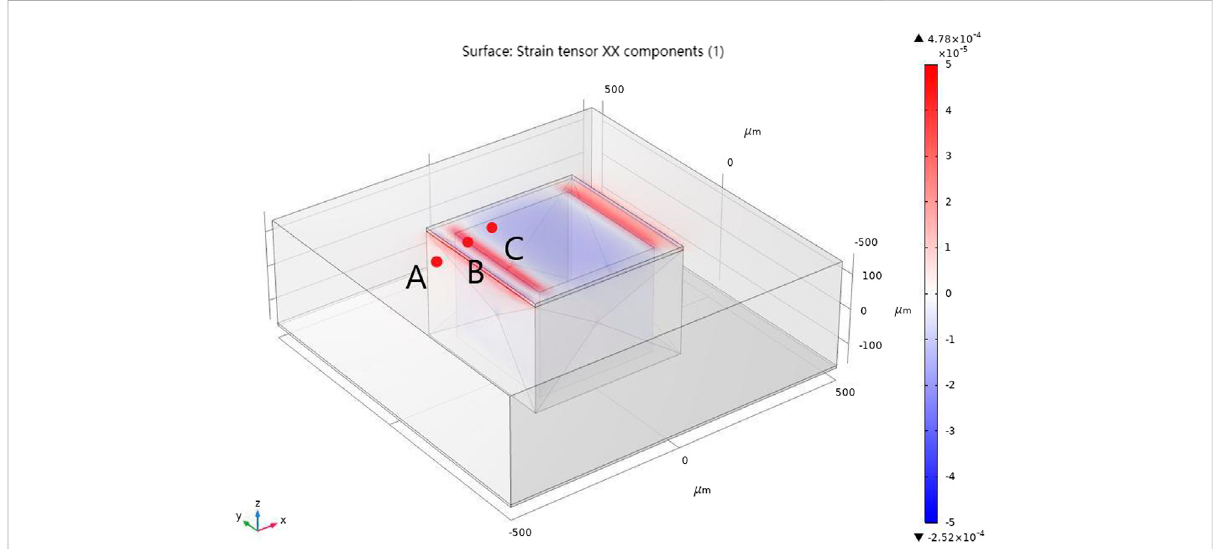
FIGURE 11 Surface strain distribution of semiconductor membranes, strain tensor: XX